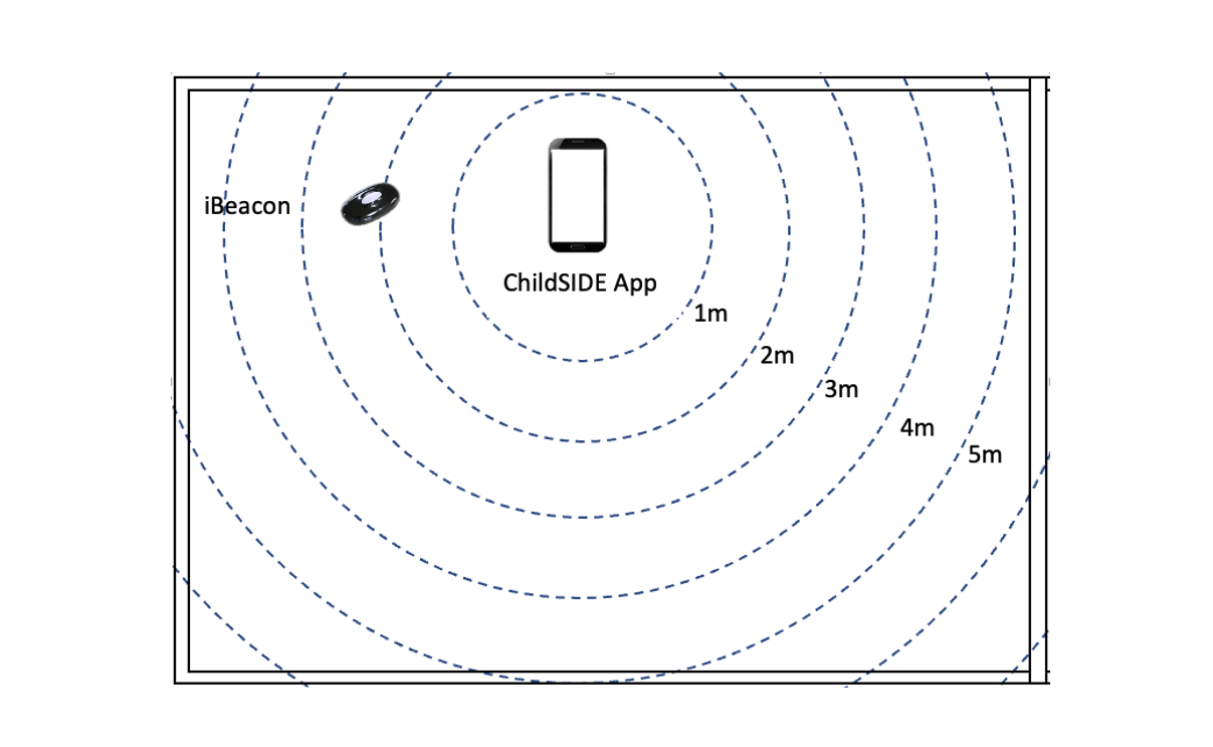
Figure 4. A sample experimental setup showing how the radio signal strength indication of iBeacon is detected by the ChildSIDE app with an actual distance of 2